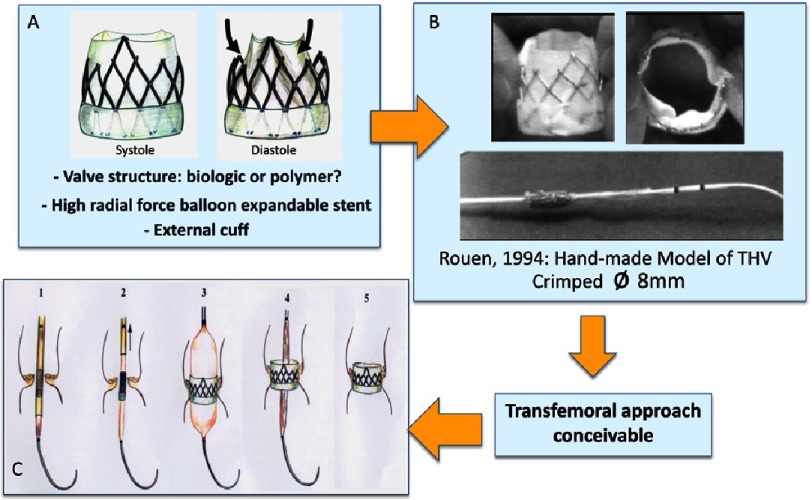
1994: Drawings and model prefiguring a balloon expandable transcatheter bioprosthesis.A: specific stent frame design allowing to attach a tricuspid valvular structure. Partial external coverage would limit the risk of aortic regurgitation through the struts. B: Hand made model of stented-valve before and after crimping over a balloon catheter (external diameter: 8 mm). C: Drawing of the different phases of transcatheter aortic valve implantation.